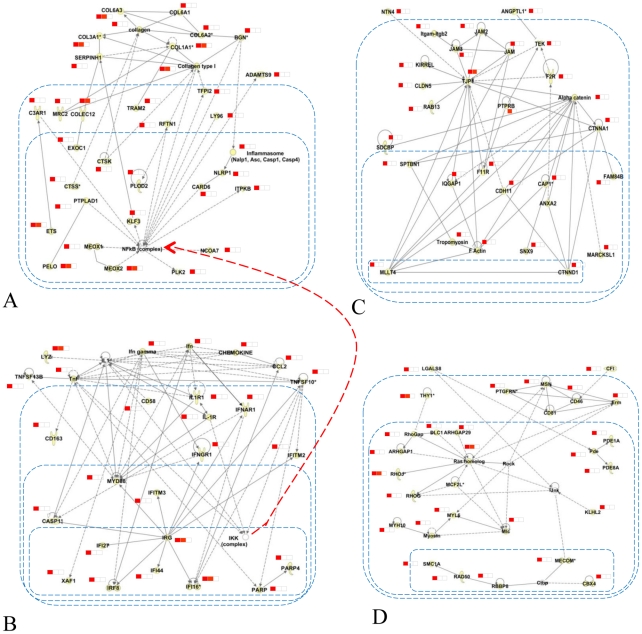
Ingenuity networks regulated by endurance training.This figure shows the most important findings derived from Ingenuity analysis using genes that are differentially expressed in response to training in healthy individuals and connected to receptor hubs in the previously inferred network. Panel A and Panel B represent two interconnected networks linked the transcription of several cytokines (IL1, TNFα, IFNγ, CCL2) and activation of the NF-kB complex (Panel A), leading to the activation of several NF-kB targets related to connective tissue formation (Panel B). Panel C shows the relationship between upregulation of gap junction complexes (JAM, JAM2, JAM3 and TJP1) and activation of important structural components of muscle fibres (e.g. tropomyosin). Panel D shows the important functional link between activation of several Rho GTPases and muscle development, represented by genes encoding for a component of the hexameric ATPase cellular motor protein myosin (MYL5) and MYH10.